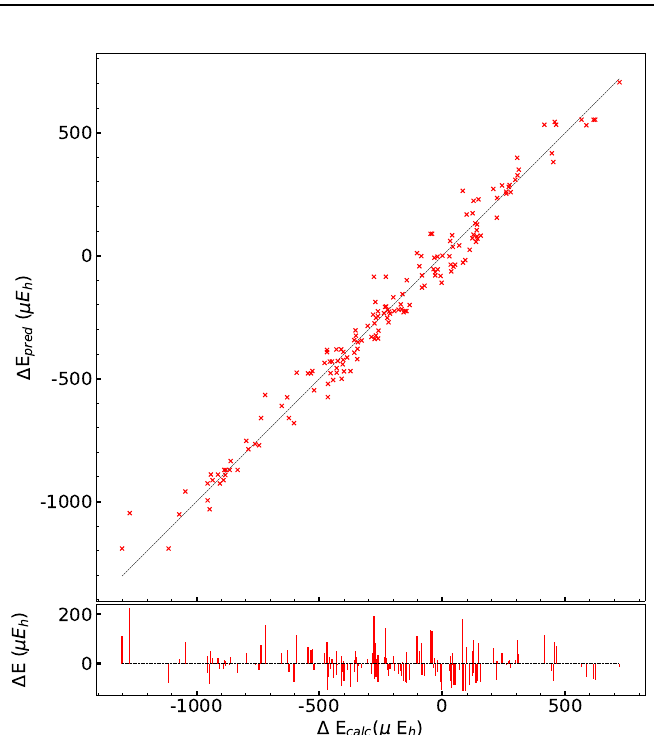
Figure A5. As in previous Figure A4, for the AFM